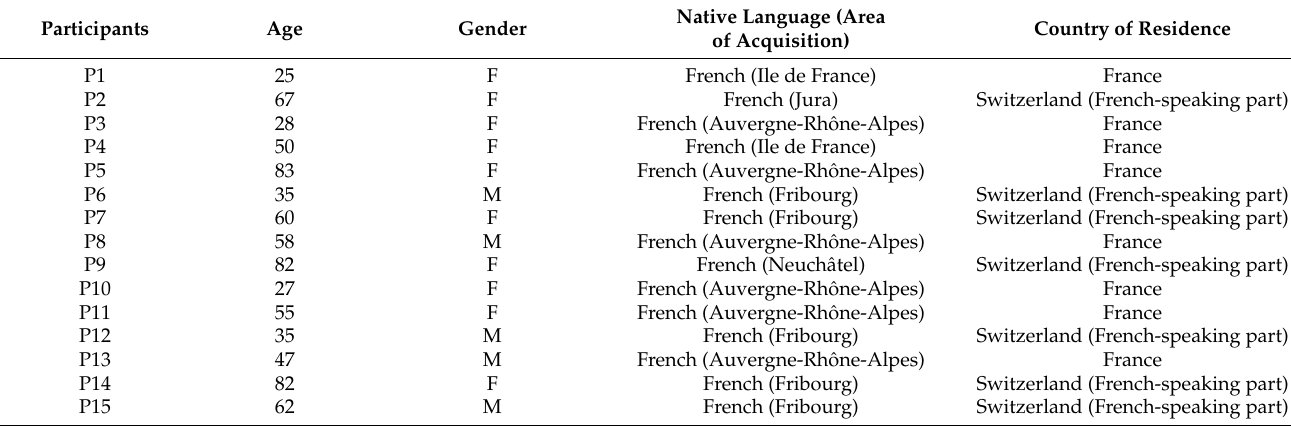
Table 1. Demographic information on the fifteen